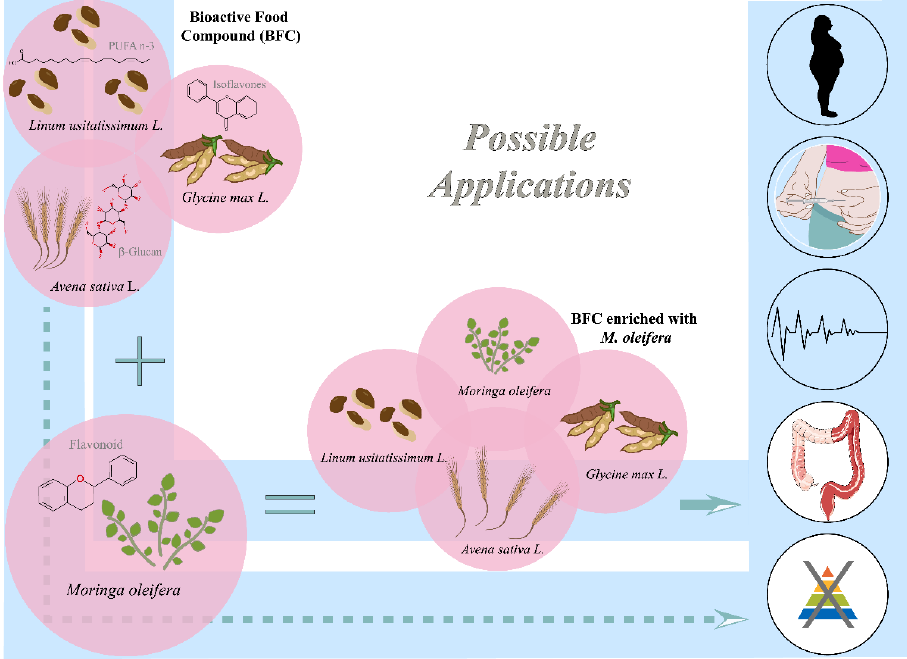
Figure 1. The nutritional and phytochemical composition of a bioactive food compound (BFC), M. oleifera and a BFC enriched with M. oleifera in NTCDs, IID and malnutrition. Some effects from functional foods, such as Avena sativa L. (oats), Linum usitatissimum L. (brown flaxseed), Glycine max L. (soya) and Moringa oleifera, have been presented for nutri- tional disorders through in vitro and in vivo tests [16–20], NCT04314258 (Tables 1 and